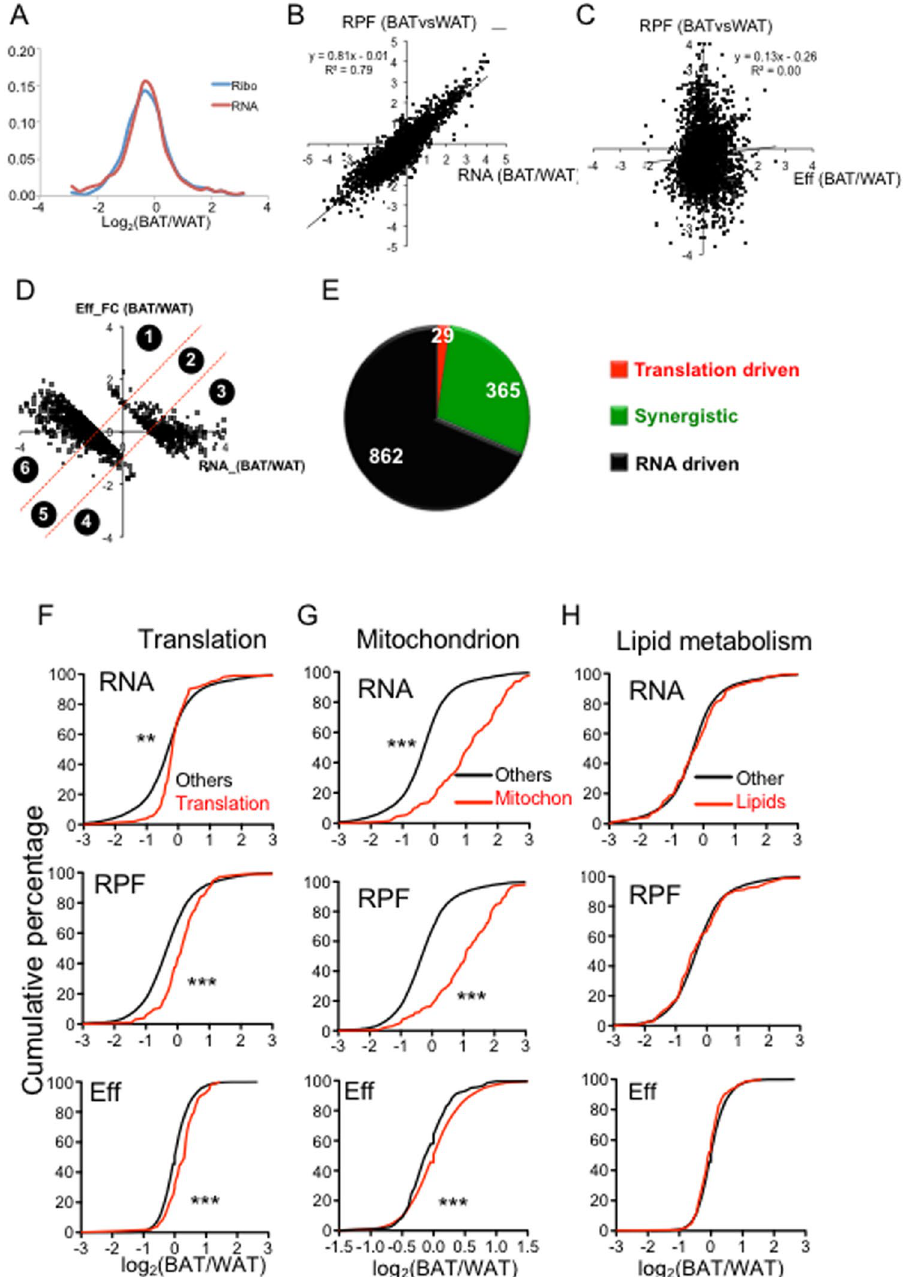
Figure 3. Comparison of the translational profiles between BAT vs WAT. ( A ) The distribution of RPF-FCs and RNA-FCs between BAT vs WAT. ( B ) Correlation between RPF-FC and RNA-FC in BAT vs. WAT. ( C ) Correlation between RPF-FCs and Eff-FCs in BAT vs. WAT. ( D ) Based on the relative contribution of mRNA- FCs vs Eff-FCs to the total translation FCs, genes with ≥ 2 fold RPF changes between BAT vs WAT were classified into 6 groups. Genes with higher and lower RFP in BAT comprise Group 1–3 and Group 4–6, respectively. ( G ) Pie chart to show the composition of each group. Genes were classified into three types: translation driven, synergistic (driven by both RNA and translation), and RNA driven. ( F ) The cumulative fraction curves of RNA- (upper), RPF- (middle) and Efficiency-(lower) FCs between BAT and WAT. The red and blue lines represent the gene population involved in translation and the total gene population, respectively. ( G , H ) Similar to H. The red line represents the genes involved in ( G ) mitochondrion and ( H ) lipid metabolism. * Represents P value < 0.05; ** represents P value < 0.01; *** represents P value < 0.001 (Kolmogorov–Smirnov